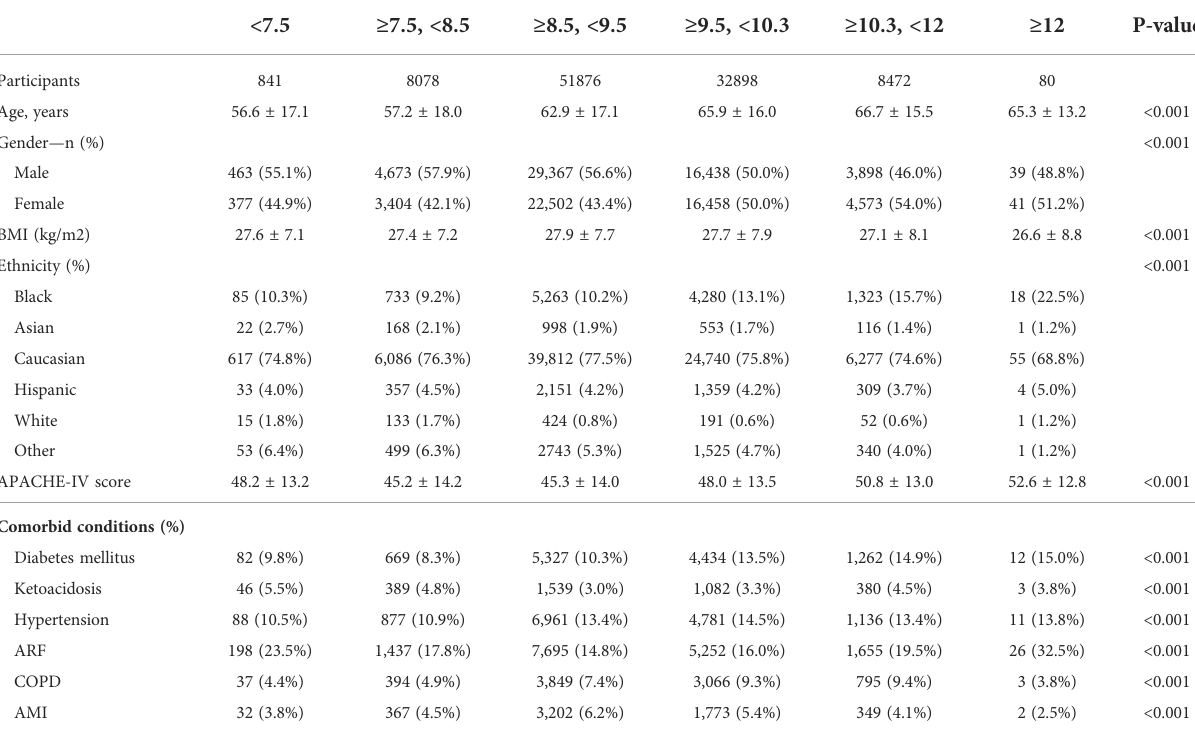
TABLE 2 The baseline characteristics of participants (N =